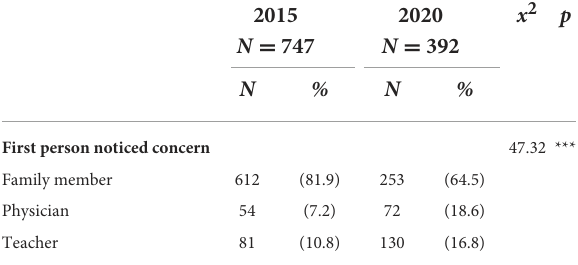
TABLE 3 Sample year and individual who noticed first developmental